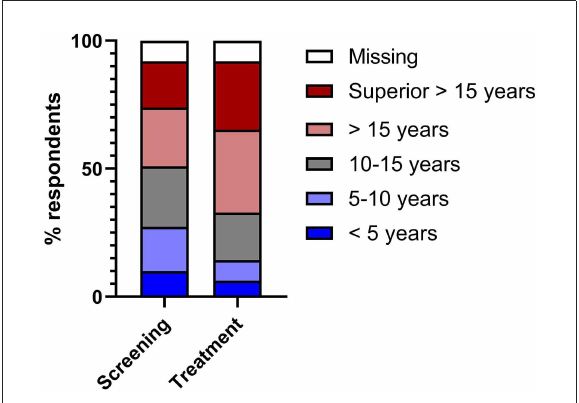
FIGURE3 100% stacked bars showing the acceptable level of error for an AI tool used for disease screening (left) and clinical decision support